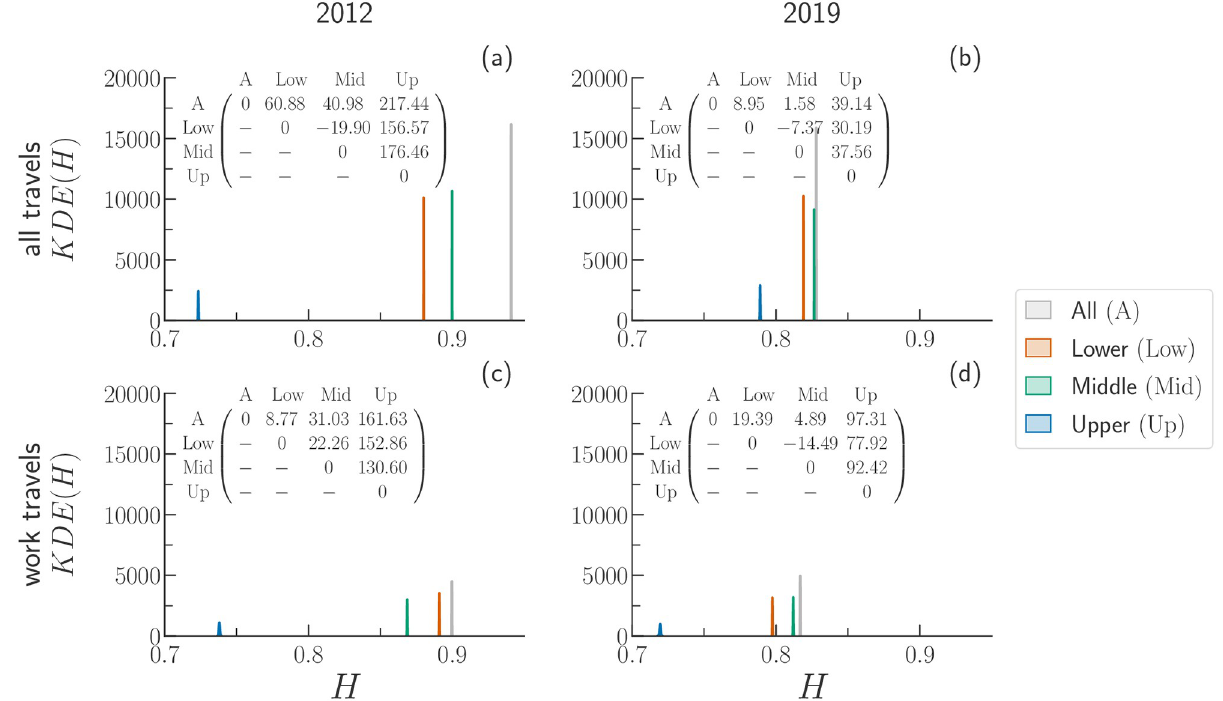
Fig 6. Kernel Density Estimation (KDE) plots of the mobility diversity, H , for travels made by travellers belonging to different socioeconomic status in the BGT area of 2012 (panels a and c) and 2019 (panels b and d). The top row (panels a and b) displays the values obtained considering all travels, whereas the bottom row (panels c and d) displays the values obtained considering only travels associated with the work purpose. We show the KDE( H ) for travels made by all travellers ( A ), as well as for those belonging to the lower ( Low ), middle ( Mid ), or upper ( Up ) socioeconomic class. The matrix appearing within each plot encapsulates the distance between the median of the distributions (peak-to-peak distances multiplied by 10 − 3 ).